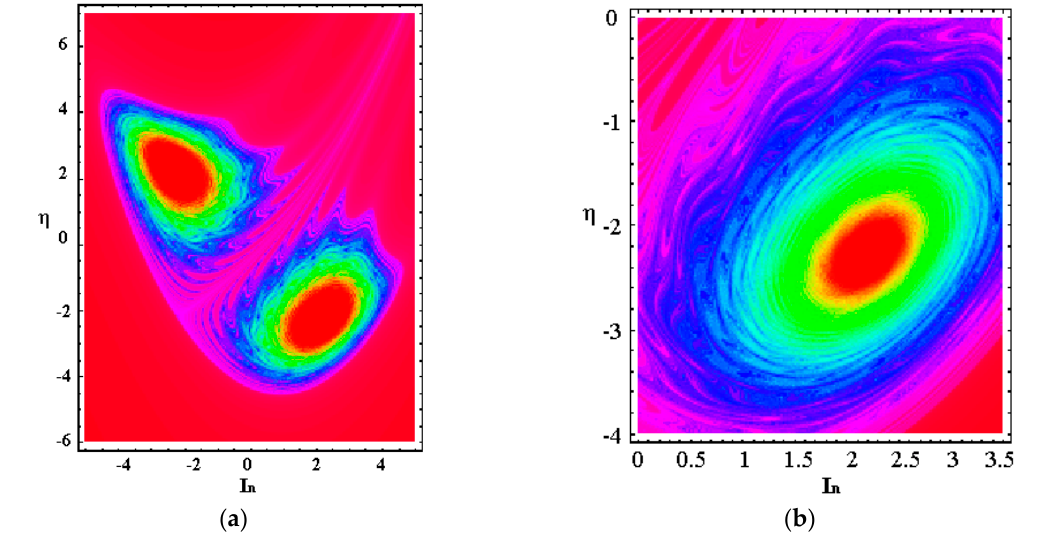
Figure 4. The non-attractive region, color indicates the number of times the iteration has escaped.